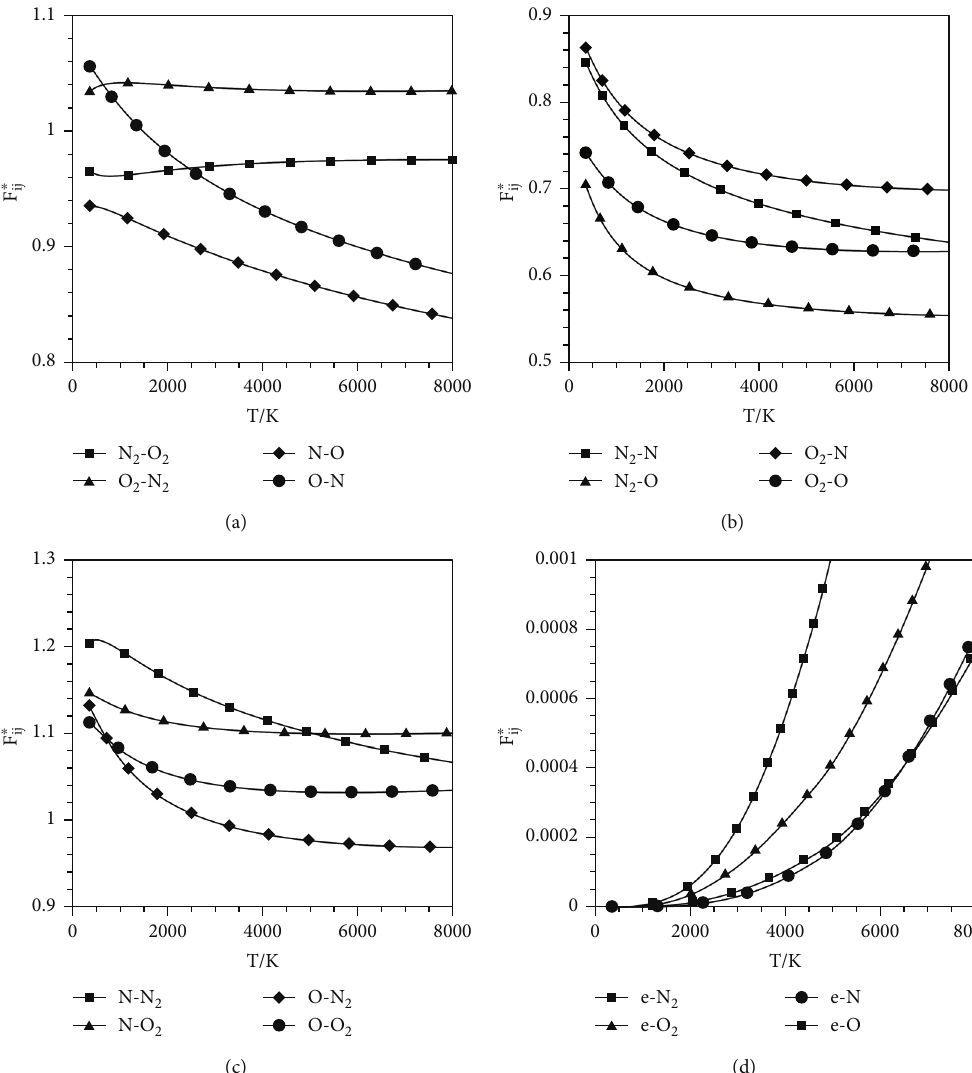
– c) F ∗ ij . (a ij related to molecules and atoms; (d)